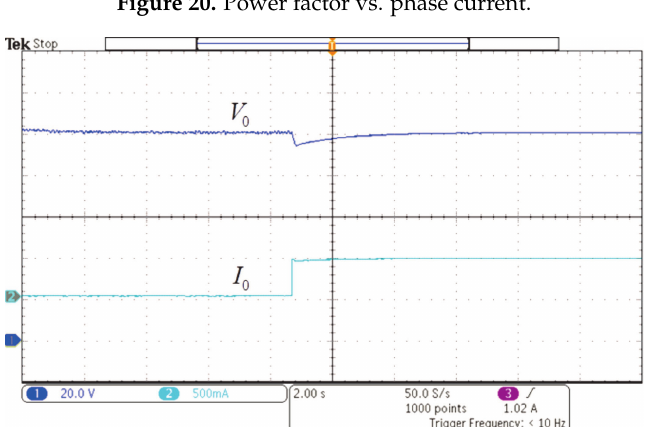
Figure 21. DC-link voltage V 0 (20 V/div) and DC-link current I 0 (0.5 A/div), for the PWM rectifier transient from no-load to high-load. V grms = 21 V and 2 s/div.